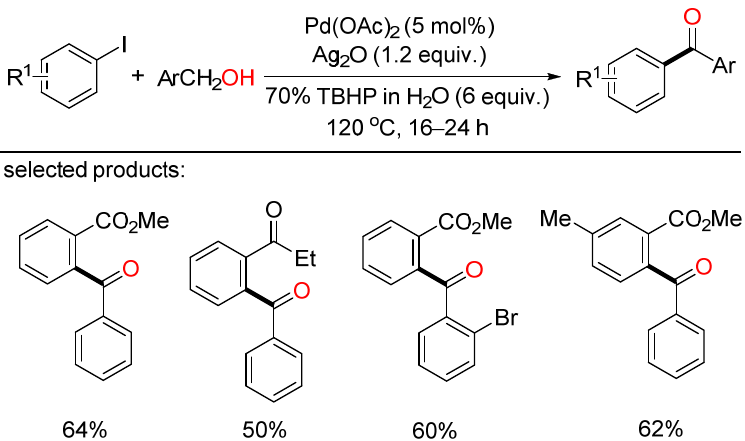
Scheme 1. Ni ‐ catalyzed cross ‐ coupling of primary alcohols and